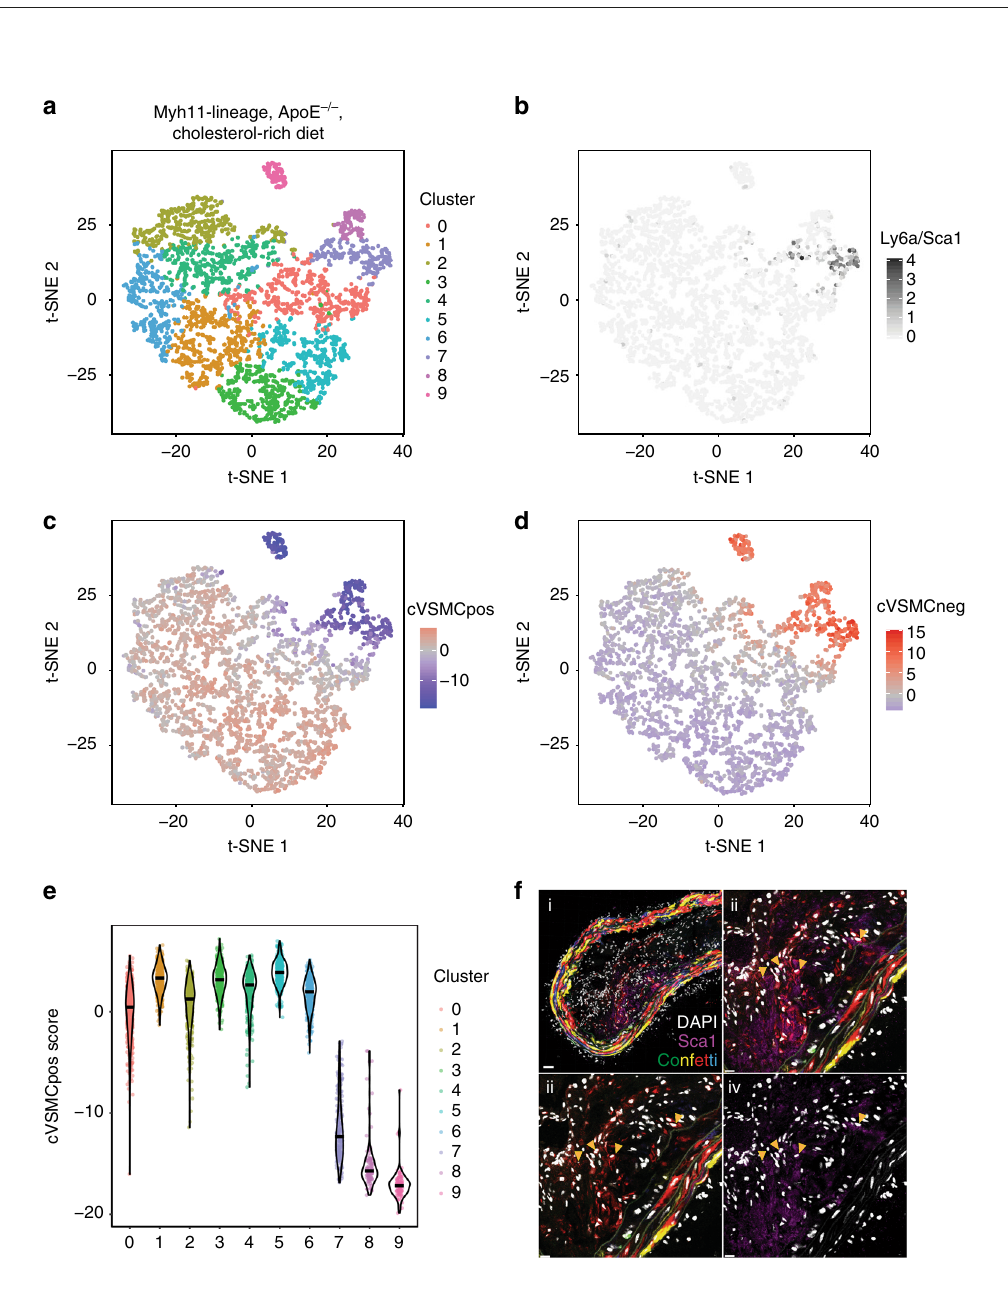
Fig. 8 Sca1 is upregulated in response to VSMC stimulation in vitro and in vivo. a Relative expression (log 2 -transformed) of Myh11 and Ly6a/Sca1 in ex vivo (black) and cultured mouse aortic VSMCs at passage 4 – 5 (red) determined by RT-qPCR, normalised to housekeeping gene expression ( Hmbs ). Lines show mean from analysis of three independent primary cultures, error bars show s.e.m. Differences in Myh11 ( p = 0.001) and Ly6a/Sca1 ( p = 5.1e − 10) expression are statistically signi fi cant (student ’ s t -test). b The PCA plot of single-cell expression pro fi les for ex vivo VSMCs (squares) and cultured VSMCs (triangles) shown in Fig. 1e, with expression level of Ly6a/Sca1 colour-coded from light to dark grey. c , d Images ( c ) and GFP-signal quanti fi cation ( d ) of FACS-isolated medial cells from Sca1-GFP animals (sorted as GFP-negative, n = 4, top row in c ) with Sca1-GFP adventitial (Adv, sorted as GFP – or GFP + (middle row in c ), tissue from four animals was pooled) and wildtype (WT) medial cell controls (sorted as GFP-, n = 1, lower row in c ). Cells were cultured for 11 days before fi xation and confocal imaging. c Epi fl uorescence images showing GFP signal after 3 or 10 days of culture. Scale bars are 100 µ m. d Quanti fi cation of GFP signal in each population showing the number of GFP-positive cells as a percentage of the total number of DAPI-positive cells. Images for quanti fi cation were taken in a single z plane. Individual replicates and their mean are indicated and error bars show s.e.m. e Logistic regression analysis of the relationship between S + L + cells and time after lineage labelling (logit-link logistic regression coef fi cient = 0.016 + / − 0.005 [mean + / − 95% con fi dence interval], p -value based on Student ’ s distribution = 2.56e − 10). Trendline and data points, colour-coded by animal age (black gradient), are shown. Age was not included in the regression model presented here; the model accounting for both time after labelling and age is shown in Supplementary Fig. 9. f , g FACS plots showing EYFP and Sca1 (APC) expression in cells from the left common carotid artery (LCCA) isolated from tamoxifen-labelled Myh11-CreERt2/EYFP no injury controls ( f ) or eight days after ligation ( g ). h The percentage of lineage labelled cells (EYFP + ) that expressed Sca1 in the LCCA isolated from ligated and no injury controls. Dots represents data from independent animals ( n = 5 for each group), lines show means, and error bars